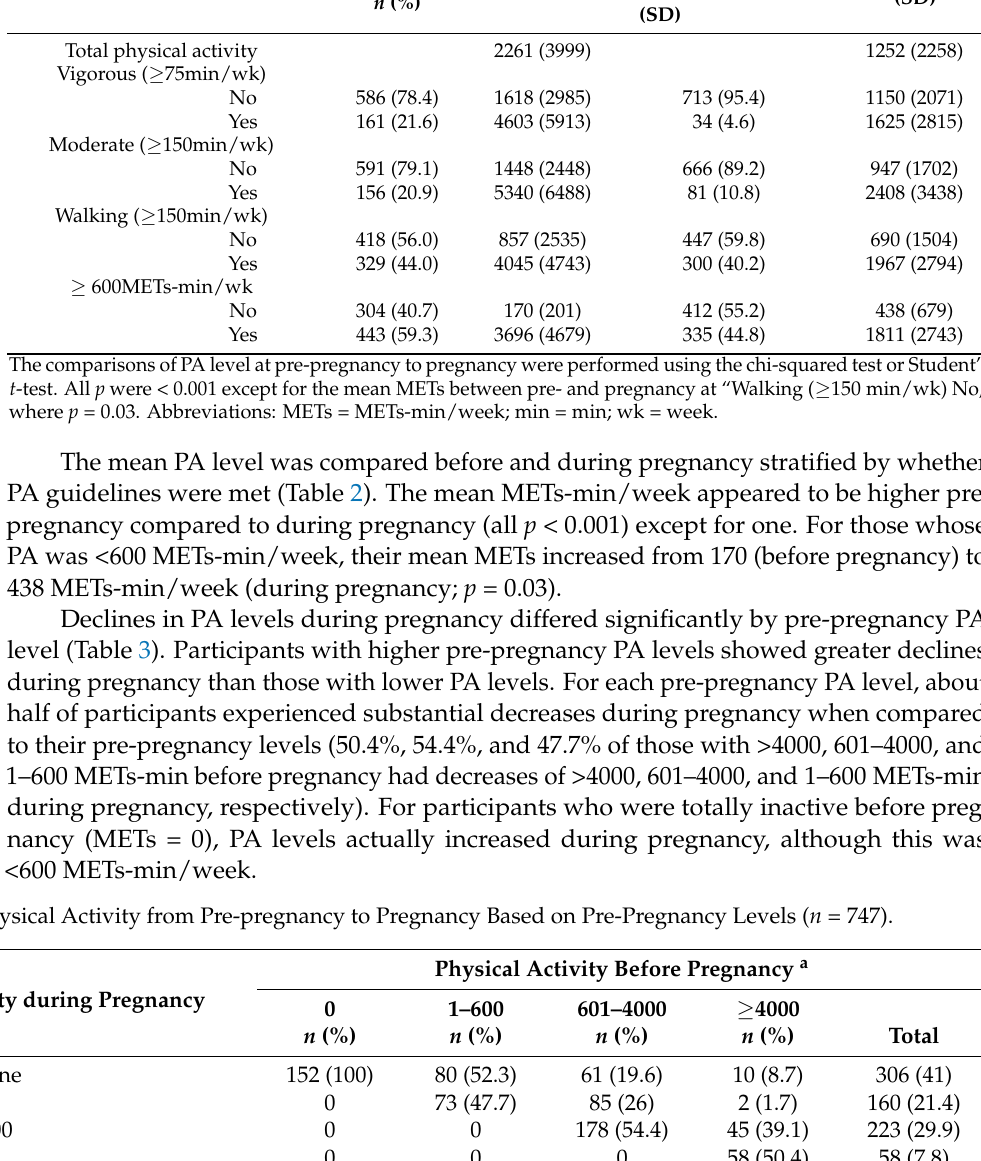
p -values obtained via Fisher’s exact test for frequency comparisons. p < 0.0001. a